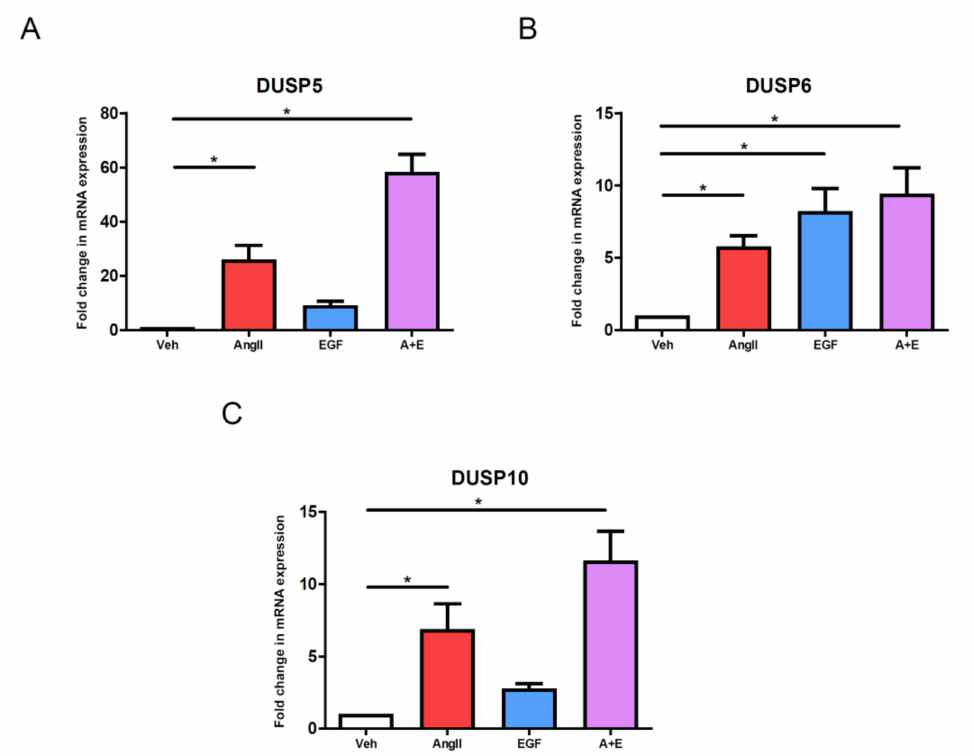
Figure 8. DUSP expression changes after simultaneous AngII and EGF stimuli in VSMCs. Serum- starved cells were exposed to either vehicle (white columns), or 100 nM AngII (red columns), or 50 ng/mL EGF (blue columns), or simultaneously 100 nM AngII and 50 ng/mL EGF (purple columns) for 2 h. RNA was isolated from VSMCs, then converted to cDNA. cDNA levels of DUSP5 ( A ), DUSP6 ( B ) and DUSP10 ( C ) were measured by qRT-PCR. The mRNA levels were normalized to values of DMSO vehicle samples and expressed as a fold change. Mean values ± SE are shown. Significance was determined with multiple linear regression (* p < 0.05). The values are from seven independent experiments ( n =